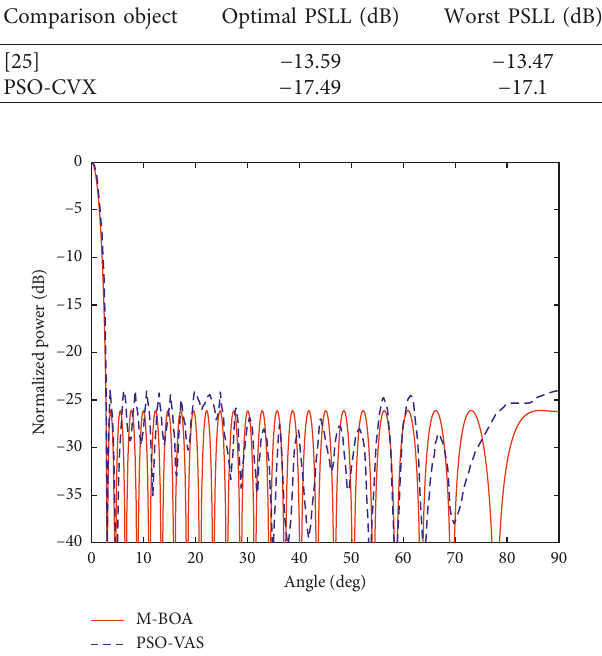
Figure 8: Pattern comparison of PSO-VAS and